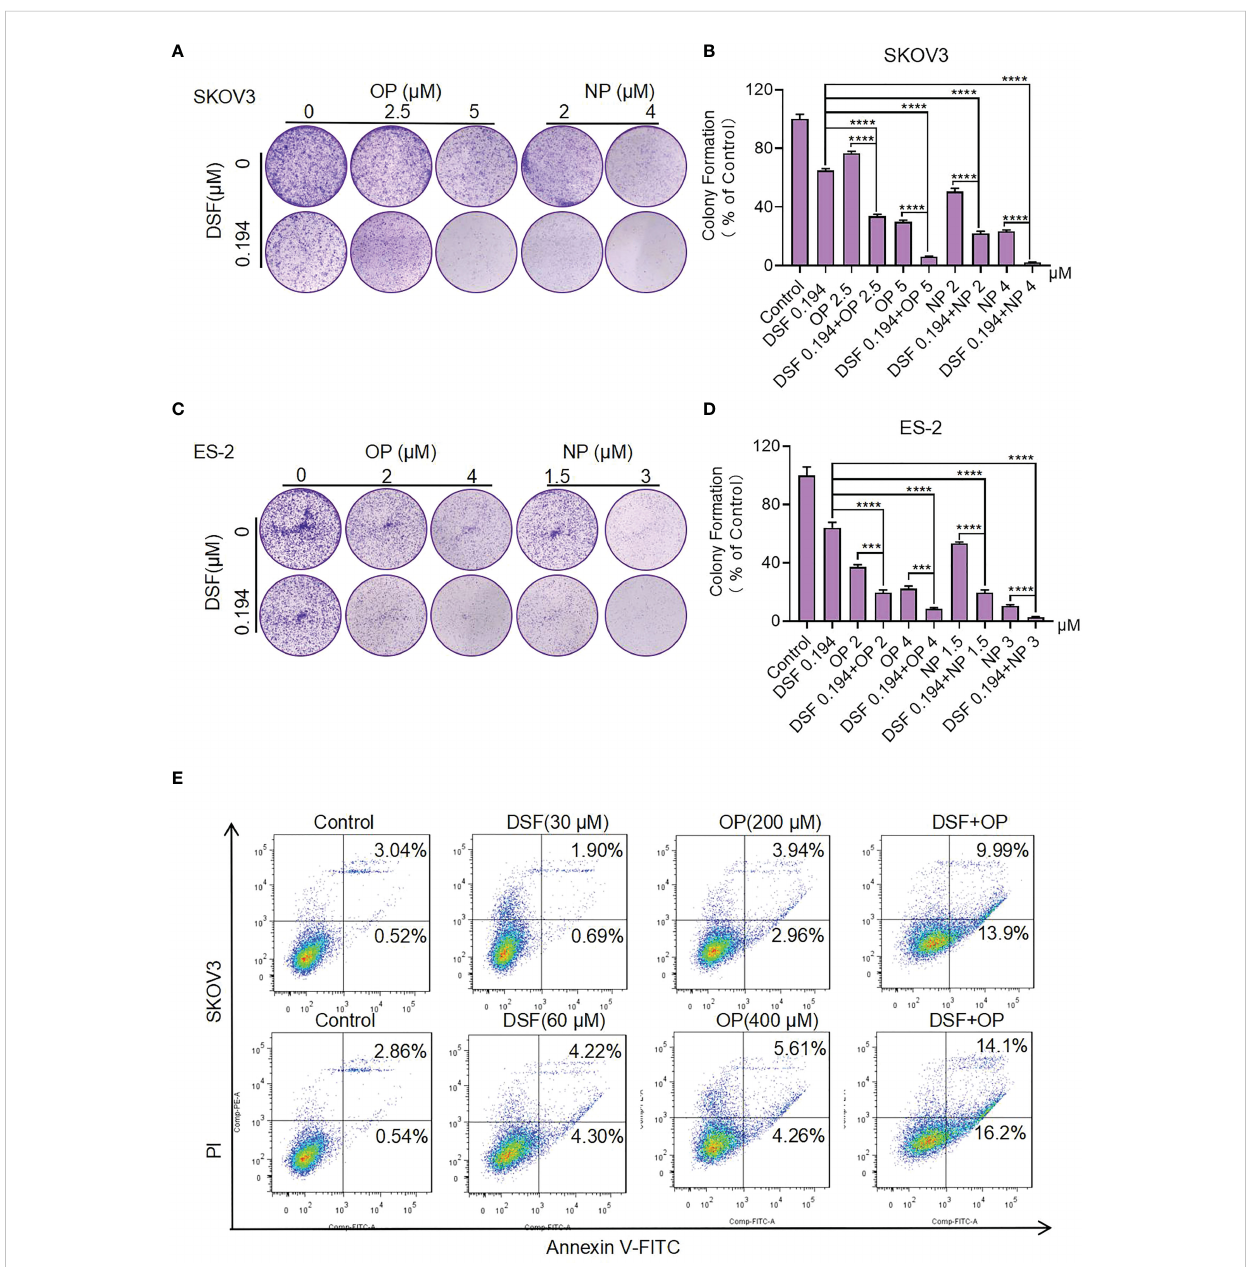
FIGURE 3 The effect of Disul fi ram in combination with PARP inhibitors on colony proliferation and apoptosis of ovarian cancer cells. Clonal Proliferation assay of SKOV3 (A, B) and ES-2 cells (C, D) treated with the indicated concentrations of Olaparib or Niraparib alone or combined with Disul fi ram. Representative images of SKOV3 and ES-2 cell colonies are shown. Apoptosis of SKOV3 cells after treatment with Disul fi ram and Olaparib alone and in combination for 48 h at different concentrations (E) . Experiments were repeated three times and represented as mean ± SD. Unpaired t-test: *** P <0.001,**** P